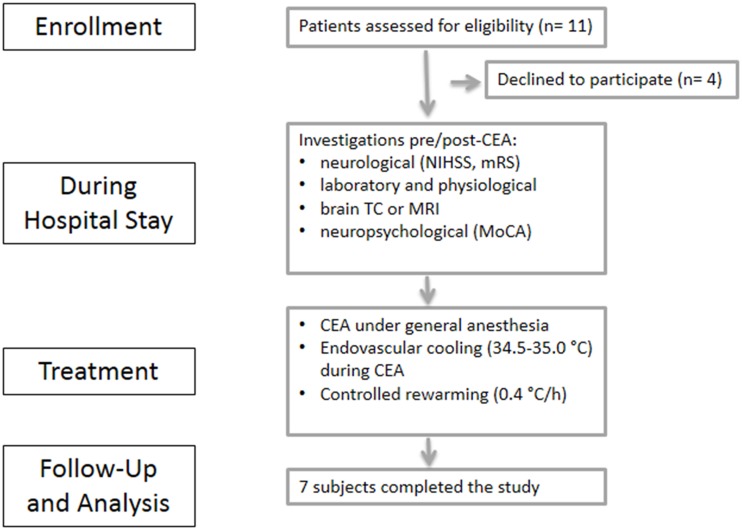
Flow chart of the study progression.